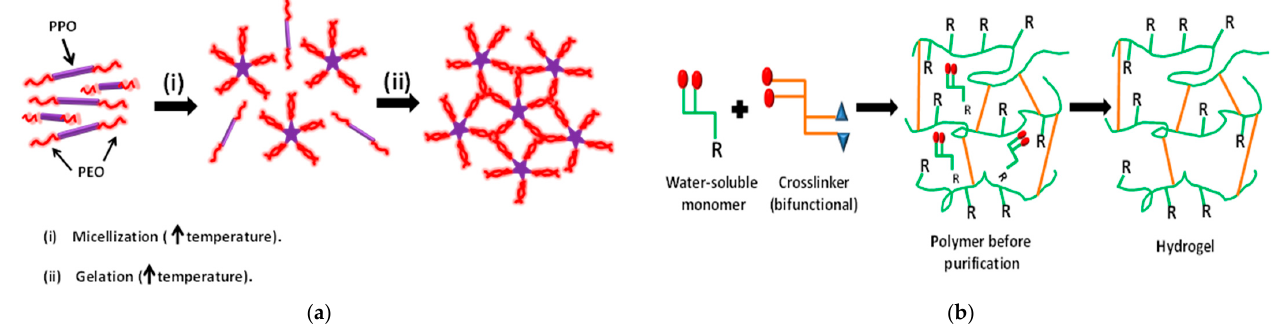
Figure 9. Illustrative representation of ( a ) physical gelation process of poloxamer and ( b ) chemical hydrogels synthesized by 3D